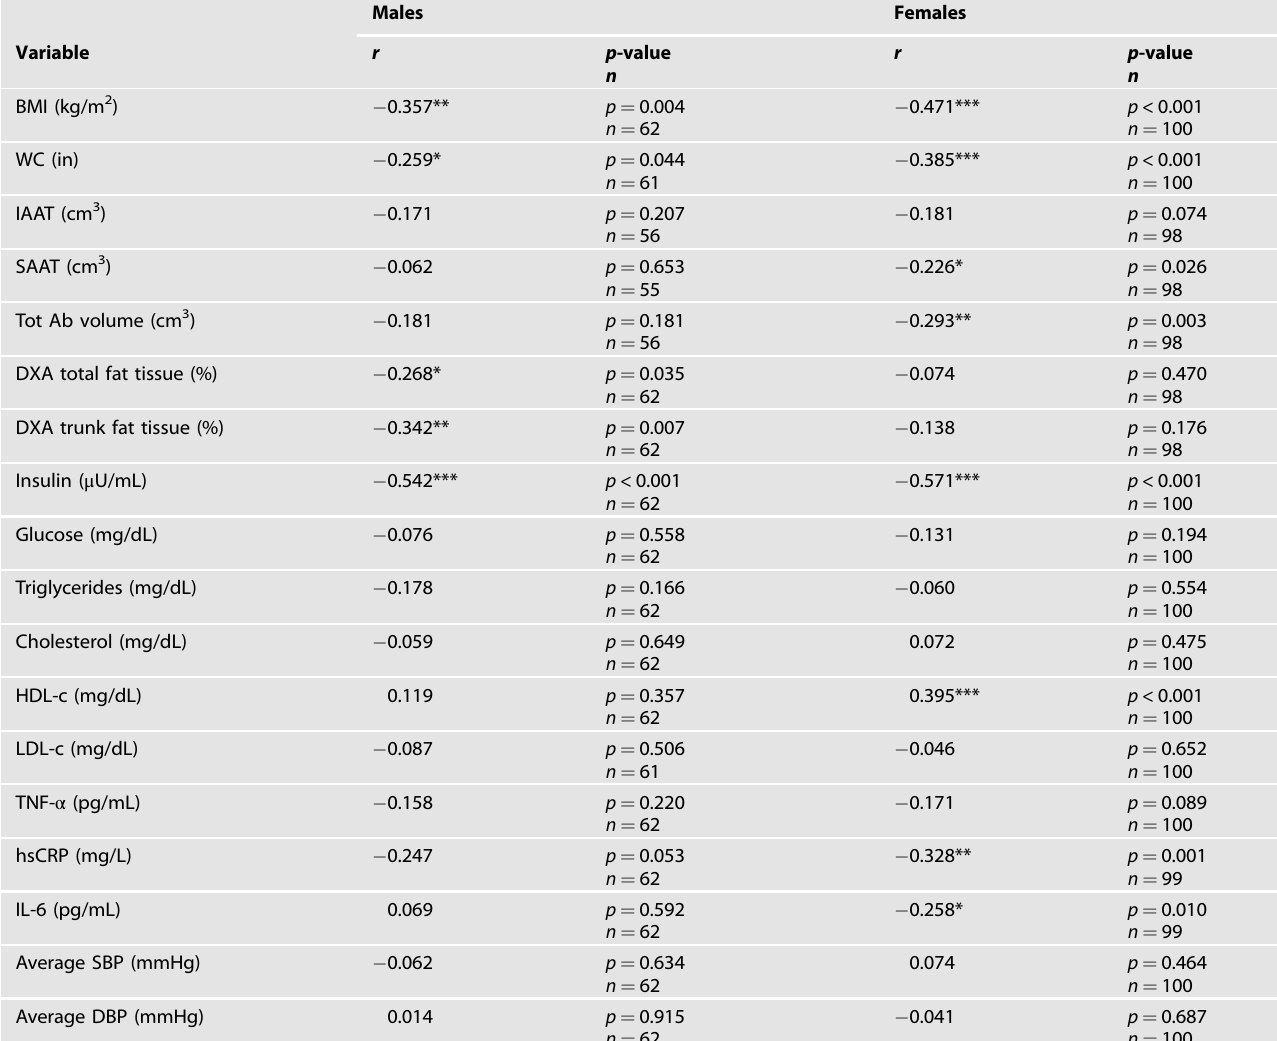
Table 2. Bivariate Spearman ’ s correlation analyses between AL ratio and measures of adiposity and cardiometabolic health at baseline among older adults with obesity following a 12-month exercise and diet